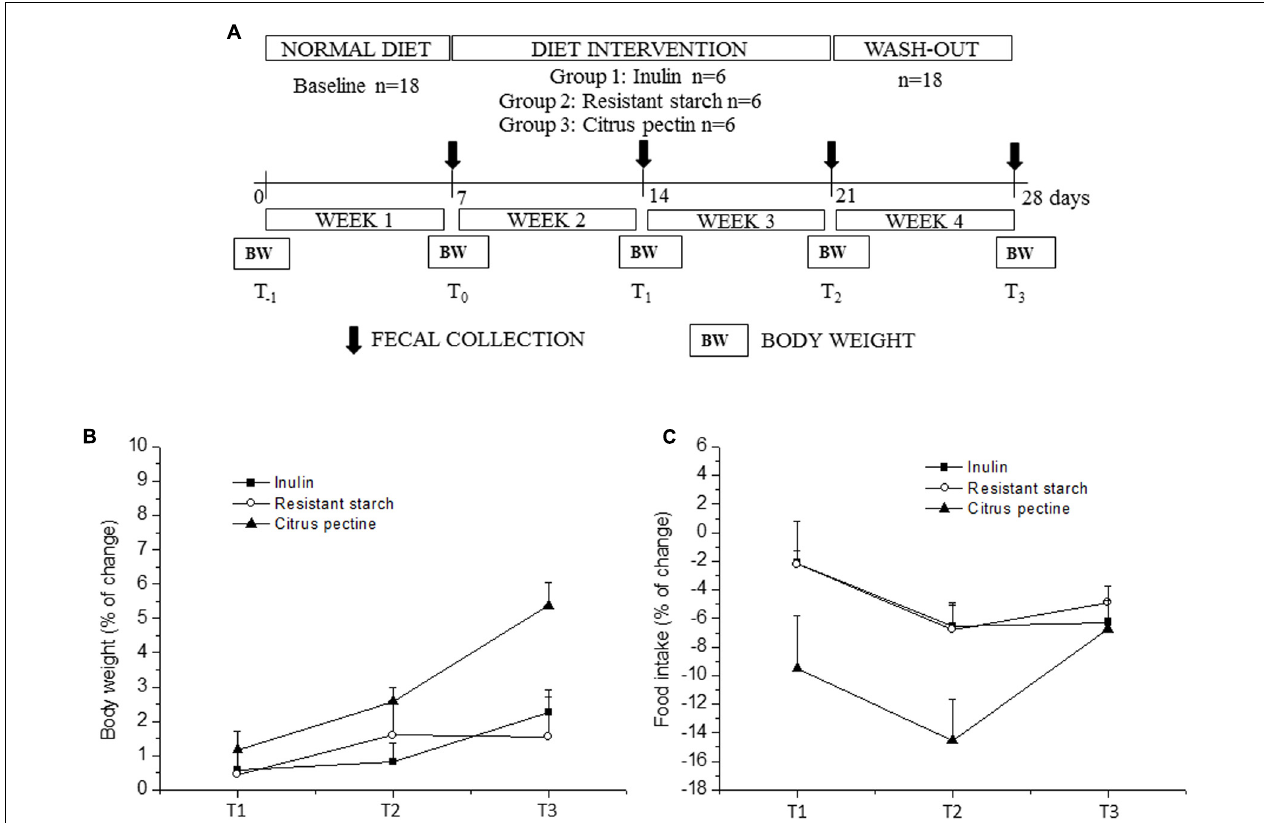
FIGURE 1 | Timeline and results of the experimental procedure. (A) shows the schedule of the experimental procedures in wild-type Groningen rats that were fed with different carbohydrate supplements: I (10%), RS (10%), and CP (3%). (B,C) Display the body weight and food intake percentage changes relative to the respective “time 0” values, during the experimental procedure, respectively. Values are expressed as means ± SEM. Statistical results are reported in the “Results” section.